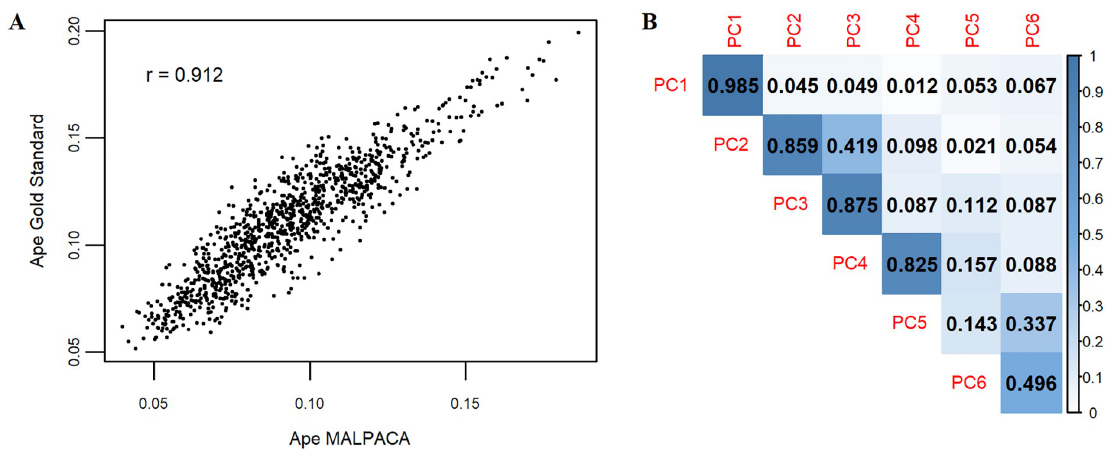
Fig 6. Ape MALPACA-Gold standard correlations in shape variables. (A) Estimated against GS pairwise Procrustes distances. (B) Correlations in the scores of the first six PCs (principal components) between estimated and GS landmarks. Each grid represents the correlation coefficient between a PC from an automated landmarking analysis and a PC from the GS, depending on its row and column names. Procrustes distances and PC scores are derived from separate GPAs of estimated and manual landmarks.